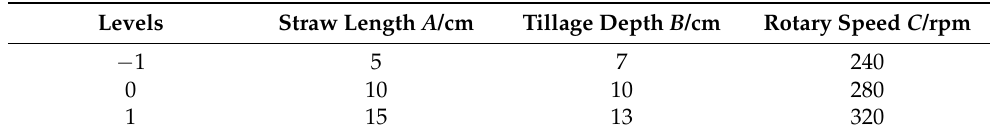
Table 2. Levels of test factors.